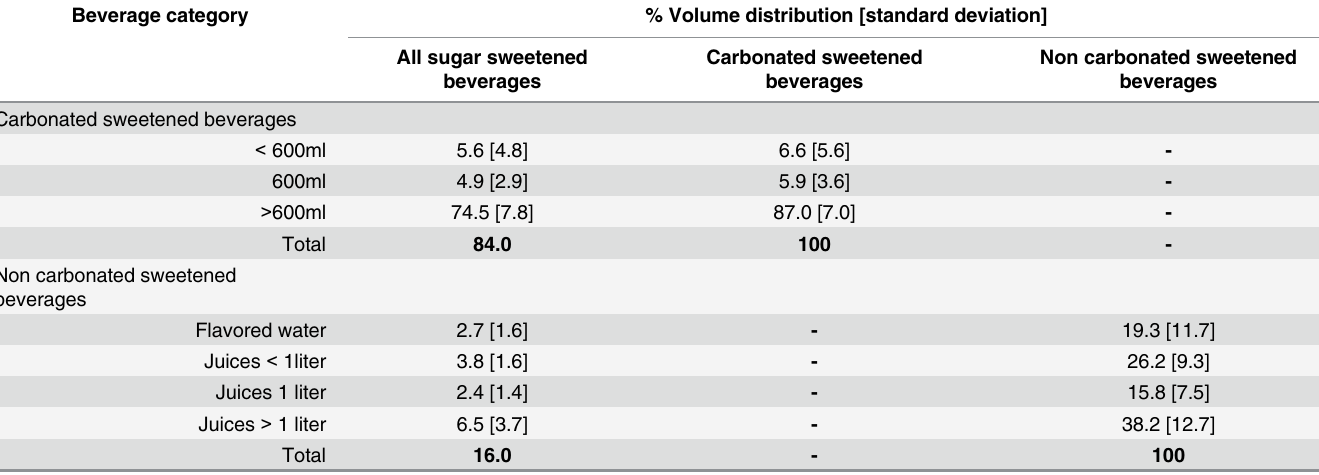
Table 1. Average volume distribution by beverage category using Nielsen purchase data.